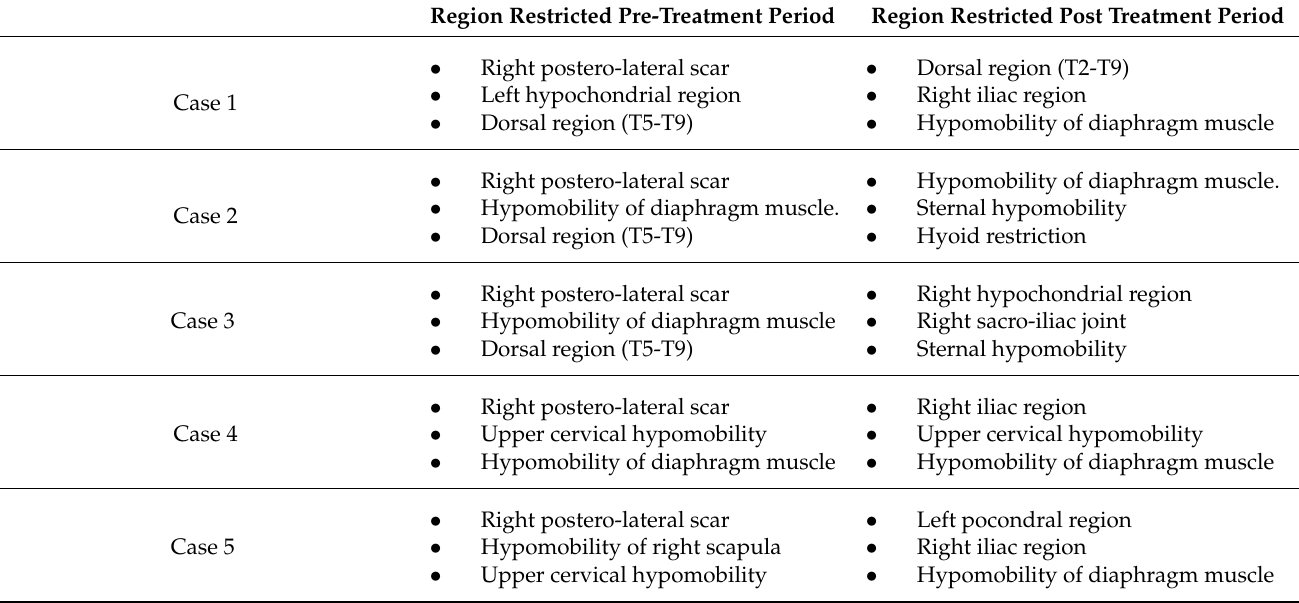
Table 3. Region restricted pre- and post-treatment